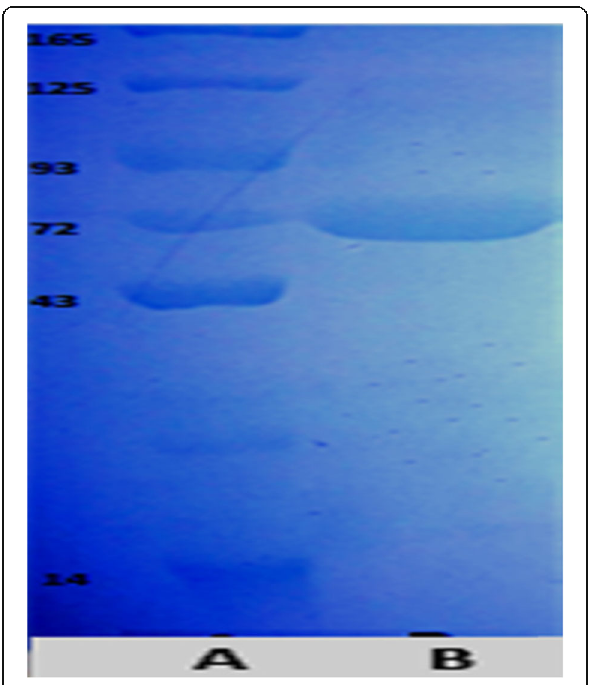
Fig. 2 Molecular weight of E. coli MKUV-Tra44 β -galactosidase by electrophoretic analysis on 7.5% SDS-PAGE. a Molecular weight marker proteins. b Purified β